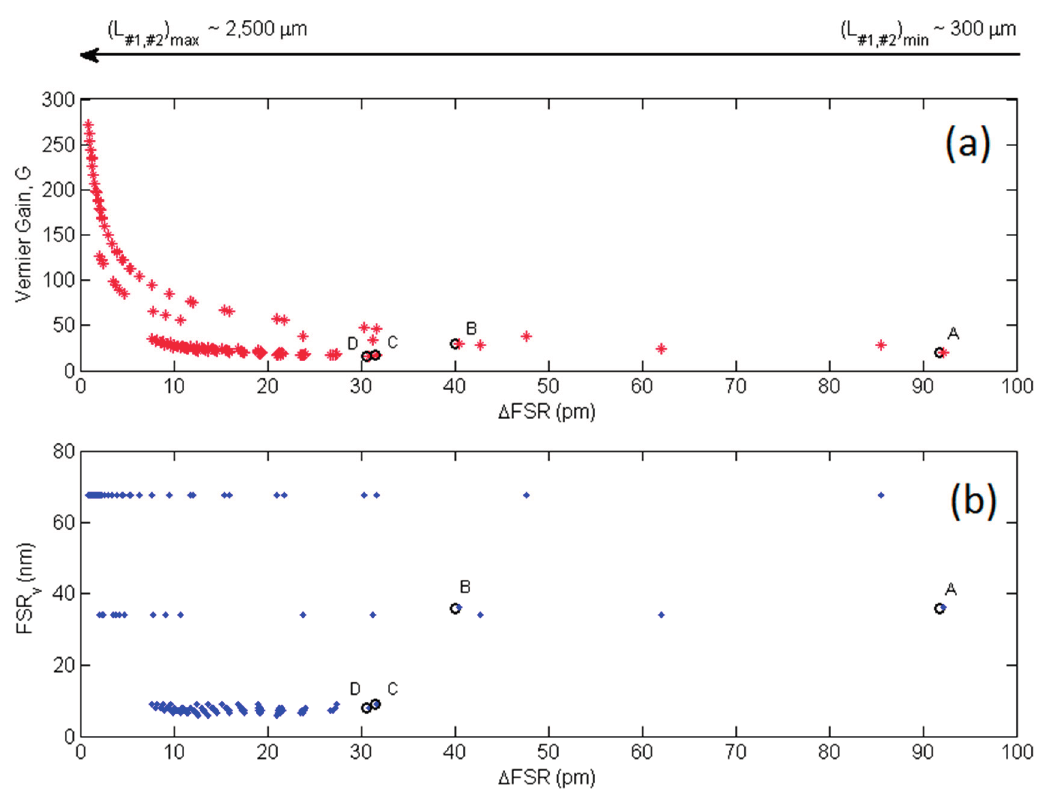
Figure 4. ( a ) Vernier gain G and ( b ) free spectral range, (cid:1832)(cid:1845)(cid:1844) corresponding to the Vernier configurations resulted from the algorithmic